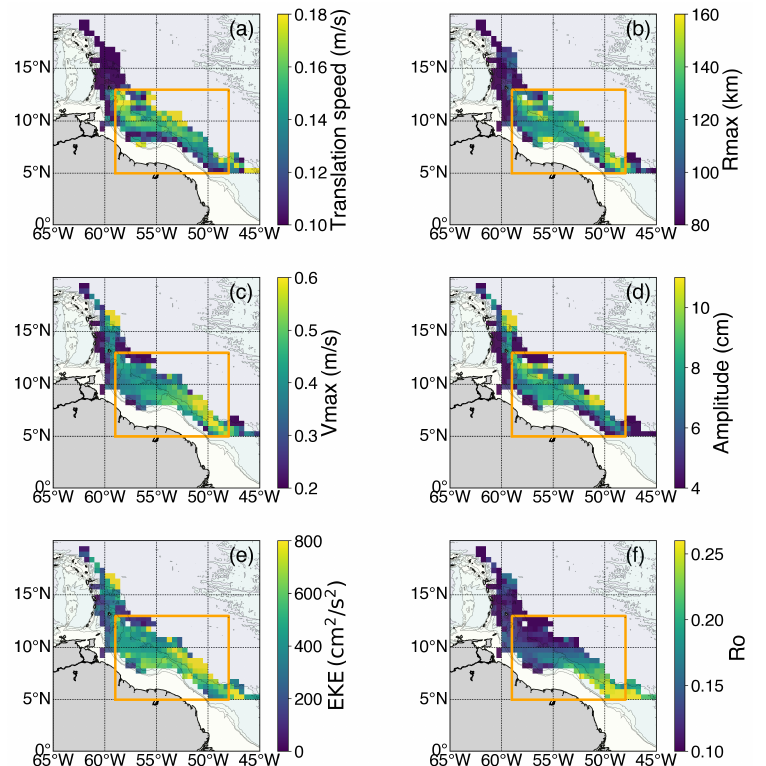
Figure 10. NBC ring mean values for different parameters: ( a ) Translation speed, ( b ) Radius max, ( c ) Azimuthal velocity max, ( d ) Normalized Rossby number, ( e ) Kinetic energy and ( f ) Amplitude. The orange box defines the region where statistics were